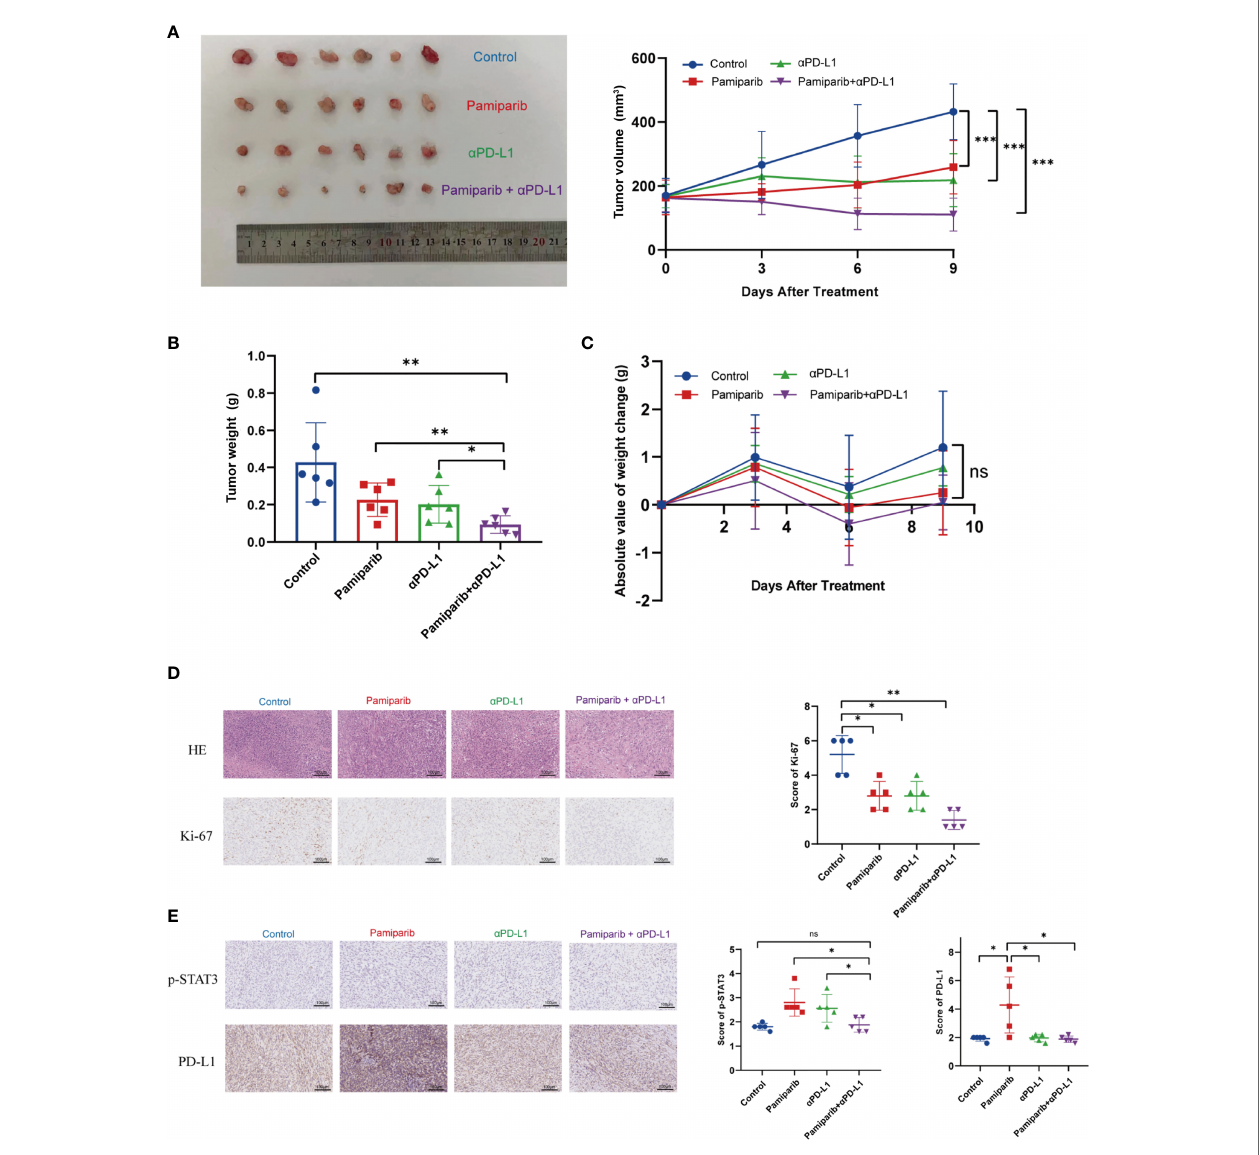
FIGURE 5 | Co-administration of pamiparib with PD-L1 blocker signi fi cantly improves the therapeutic effect in vivo . (A) Tumor volume curves of C57 mice carrying Pan-02 allograft tumors in different treatment groups (n = 6) and tumor pictures at the end of treatment. (B) Tumor weight histograms of Pan-02 allograft mice in different treatment groups (n = 6). (C) Bodyweight curves of mice in four different treatment groups at the indicated time points after receiving treatment. Data analysis was performed by unpaired t-test. (D) Representative images of H&E and Ki-67 IHC staining of Pan-02 allograft tumors in mice from different treatment groups (n = 5). Scale bar, 100 m m. (E) IHC staining and scores showing consistent trends in PD-L1 and p-STAT3 changes were observed between the four groups of C57 (n = 5). Scale bar, 100 m m. * P < 0.05, ** P < 0.01, *** P < 0.001, ns differences were not statistically signi fi